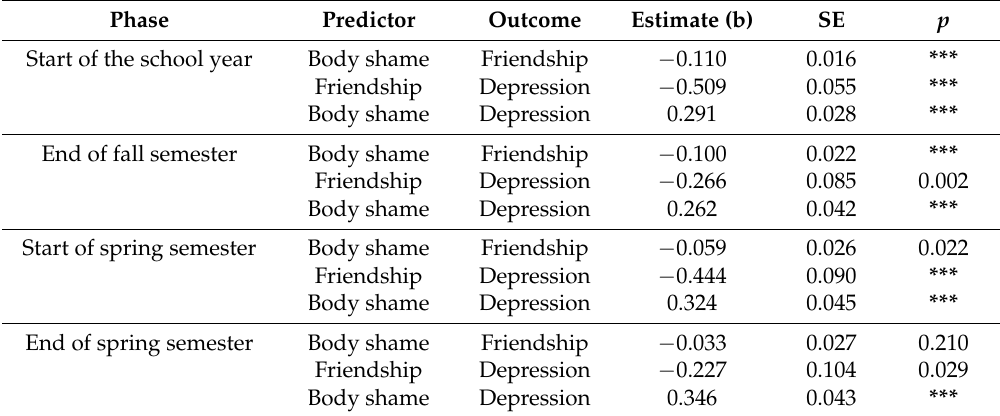
Table 3. Mediation analysis examining friendship on the relationship of body shame to women students’ depression levels ( n = 927). *** p < 0.001.